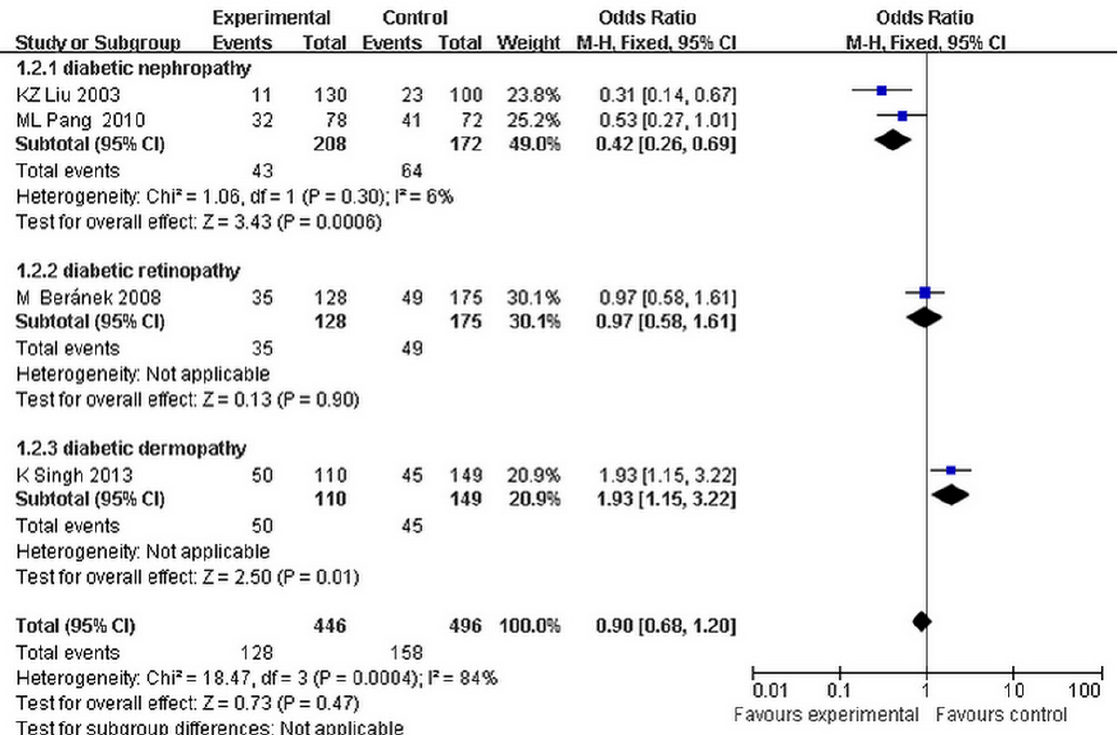
Figure 2. Forest plots of the meta-analysis for MMP9-1562C to T gene mutation (CT + TT vs. CC) associated with the subtypes of diabetic microvascular